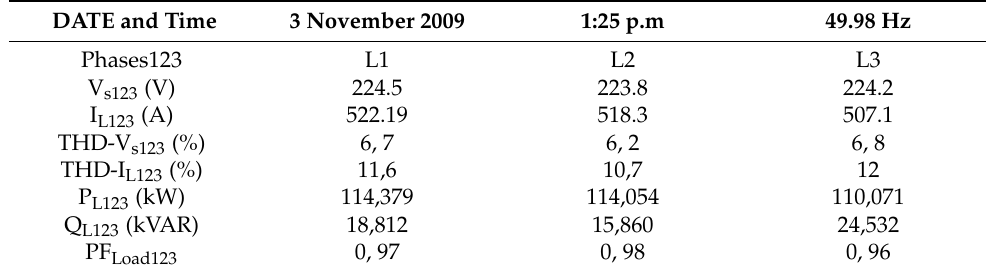
Table 7. Electrical network